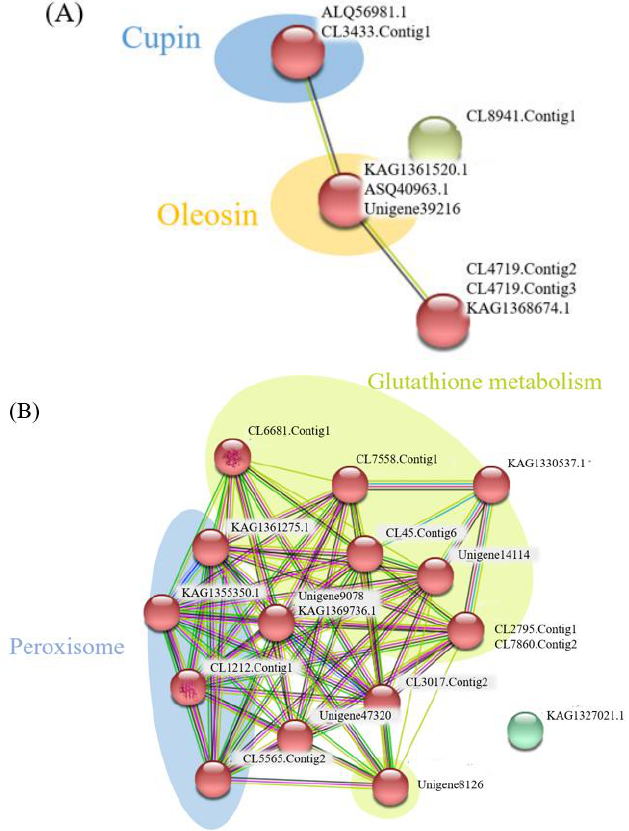
Figure 3. Protein network for the globulin ( A ) and antioxidant proteins ( B ) using the STRING (v11.0) software. The solid lines represent the physical direct interactions .